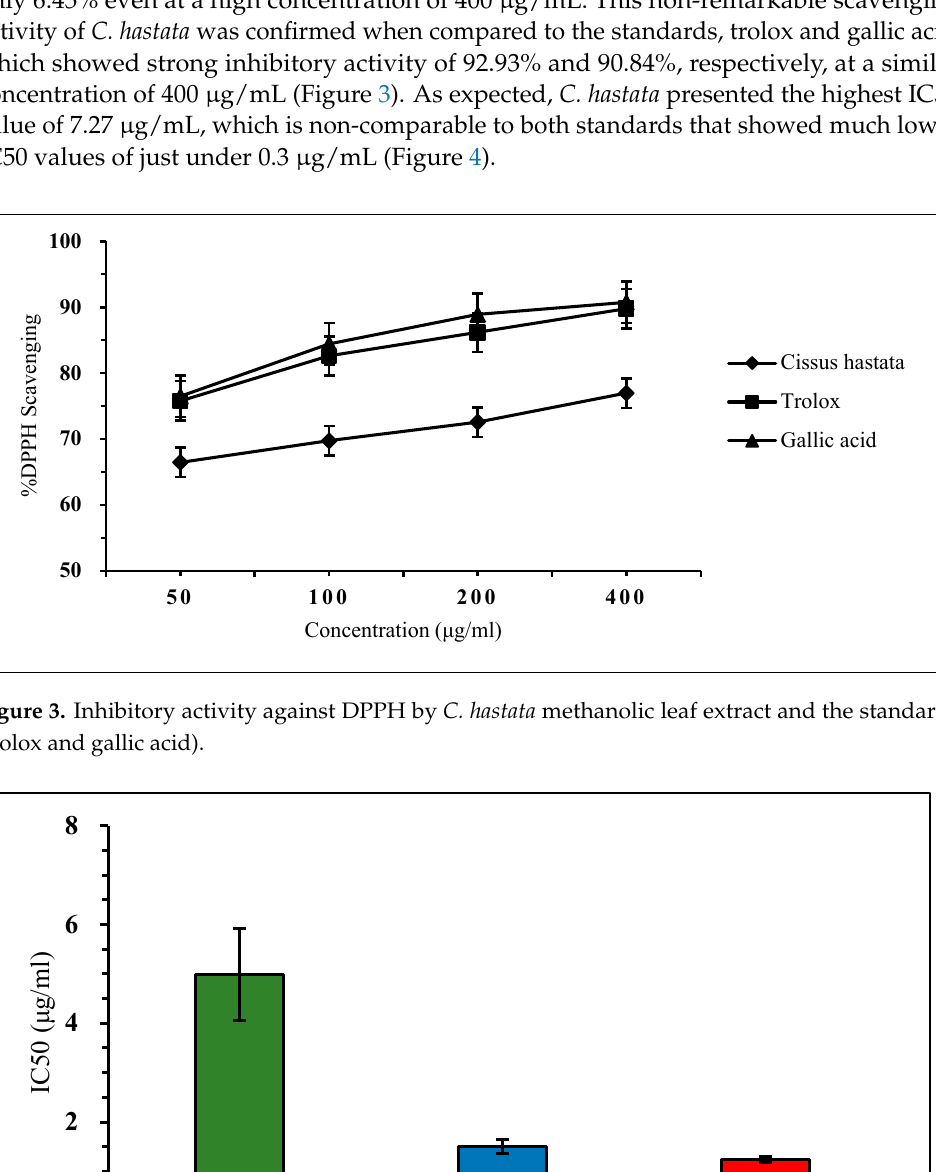
Figure 3. Comparison of the IC50 value (DPPH radical scavenging activity) among C. hastata methanolic leaf extract, trolox, and gallic acid.